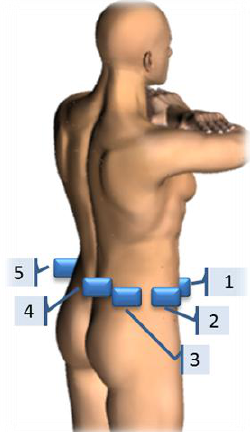
Figure 3. The five sensor locations around the waist. Sensor location 1 = Right hip anterior position; 2 = Right hip most lateral position; 3 = Right hip posterior to position 2; 4 = Sacrum position; and 5 = Left hip most lateral